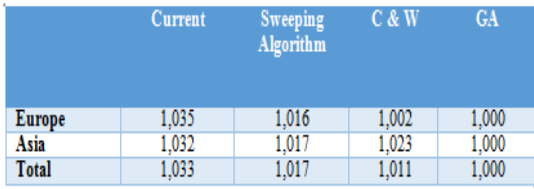
Table 4 : Comparison of solution (%).